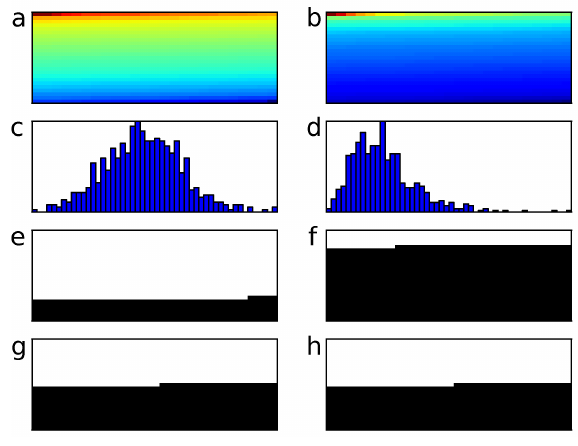
Fig. 4. Illustration of the effect of a bias on the binary masks as defined in Sect. 2.2.1. (a) and (b) are two sample data array where Fig. 5. Illustration of the effect of differences in distributions in the (b) displays a bias with respect to (a) . (c) and (d) are the binary two datasets. (a) and (b) are two sample data arrays where (b) is a masks obtained considering an absolute threshold that is the overall of the effect of a bias on the binary masks as defined in section Fig. 4 : Illustration power function of (a) . (c) and (d) are their respective histograms. Fig. 5 : Illustration of the effect of differences in distributions in the two datasets. a mean value of (a) and (b) . (e) and (f) are the binary masks obtained (e) and (f) are the binary masks obtained considering an absolute 2.2.1. a and b are two sample data array where b displays a bias with respect to a . and b are two sample data arrays where b is a power function of a . c and d are their using the quantile approach introduced in Sect. 2.2.1. threshold that is the overall mean value of (a) and (b) . (g) and (h) c and d are the binary masks obtained considering an absolute threshold that is the are the binary masks obtained using the quantile approach intro- respective histograms. e and f are the binary masks obtained considering an absolute duced in Sect. 2.2.1, i.e. the median in this overall mean value of a and b . e and f are the binary masks obtained using the quantile threshold that is the overall mean value of a and b . g and h are the binary masks approach introduced in section 2.2.1. obtained using the quantile approach introduced in section 2.2.1, i.e. the median in this case